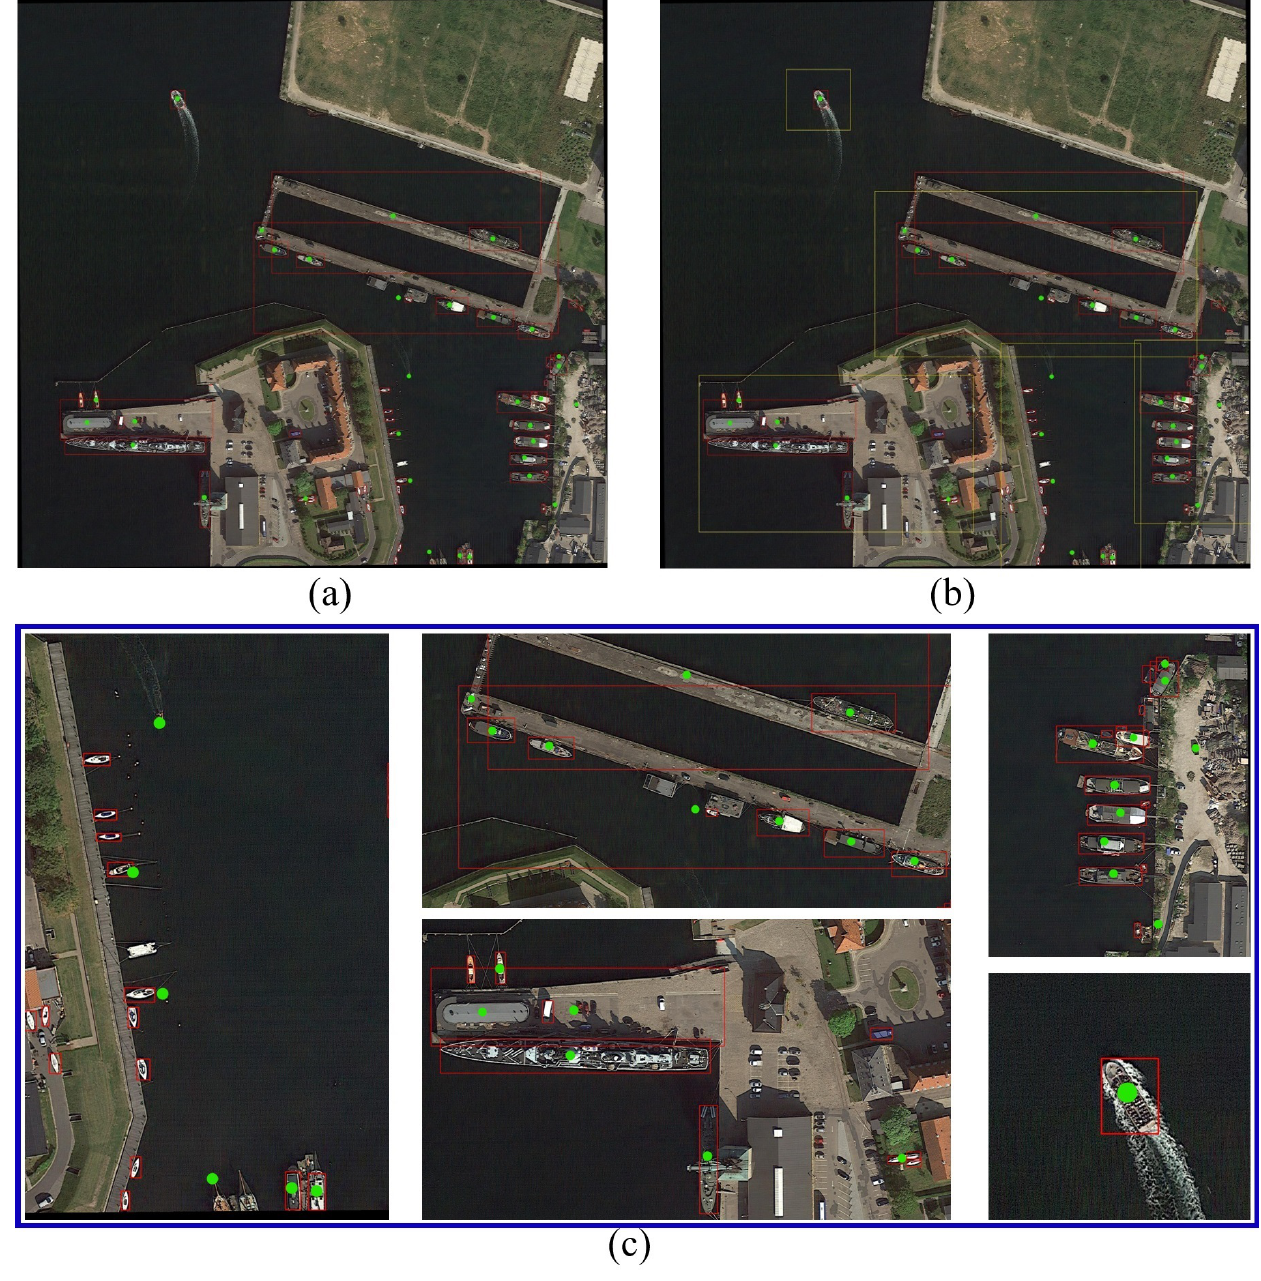
Figure 3. Typical example of key-point guided rough object position extraction. The red boxes are the ground truth bounding box annotations, while the green dots are the detected key points generated from our key-point detector, and the yellow boxes are the round regions extracted by our data